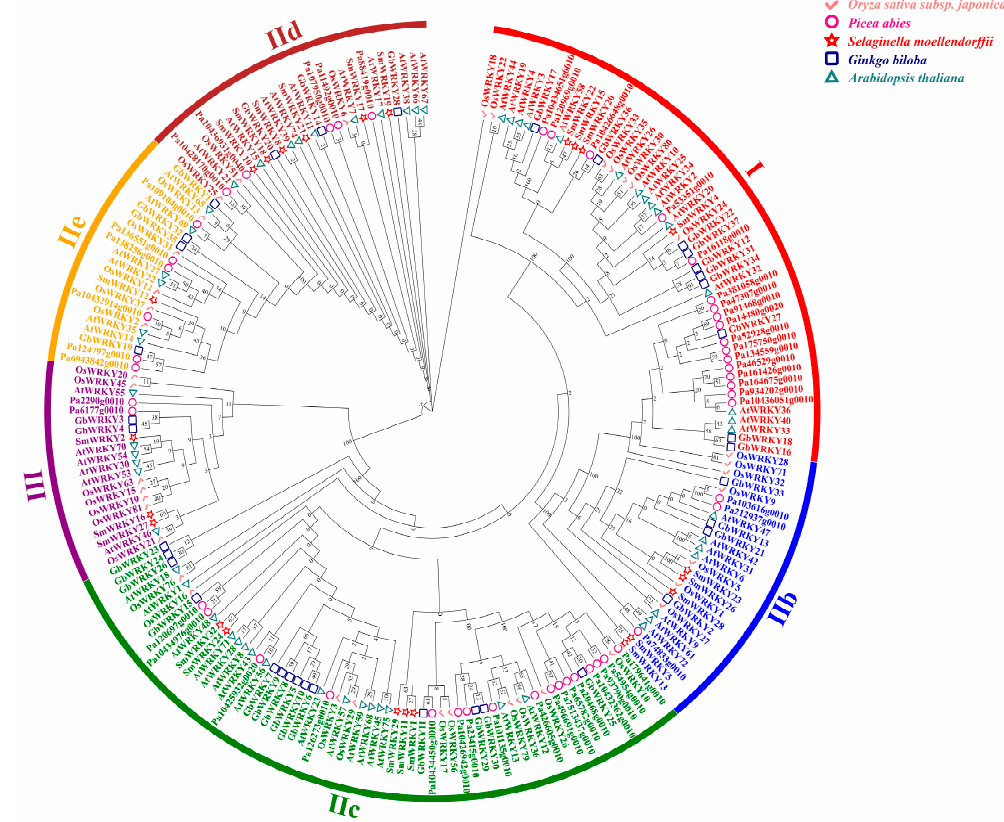
Figure 3. The phylogenetic tree of the WRKY proteins in G. biloba , A. thaliana , O. sativa , S. moellendorffii and P.abies.3.6. Tissue − specific expression analysis of GbWRKY genes.